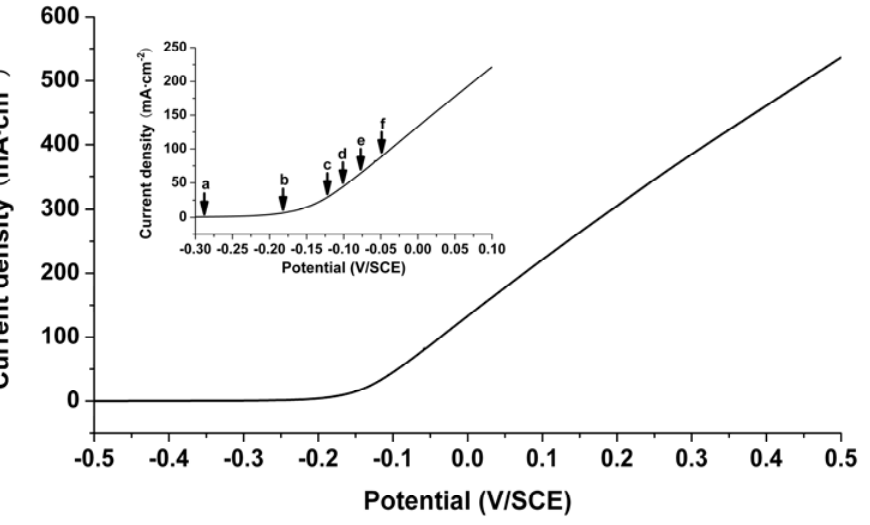
Figure 6. Potentiodynamic polarization curve of the iron electrode in 0.5 M NaCl solution at 10 mV·s − 1